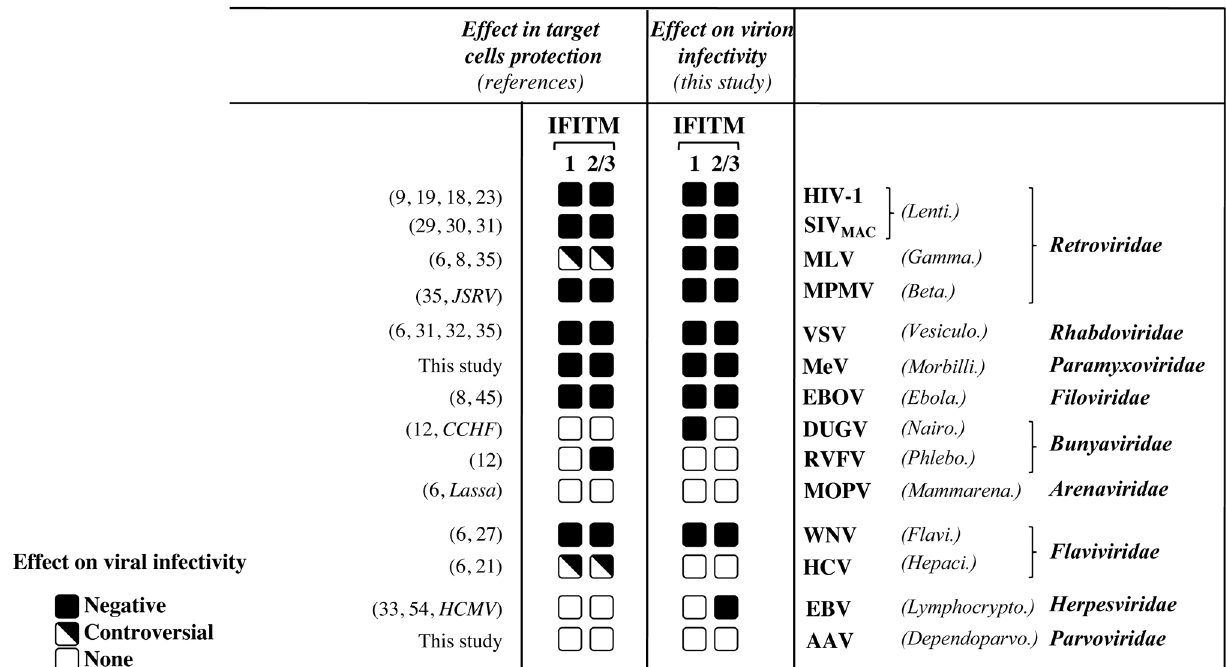
Fig 10. Comparison between the antiviral effect of IFITMs reported in the literature for the different viruses and mediated by the pool of IFITM proteins in target cells, with the negative imprinting of the virion particles infectivity reported in this study. Given their high identity, the antiviral effects of IFITM2 and 3 are presented together, separately from those of IFITM1. Variationsin the magnitude of the antiviral effects reportedin the different studies have not been taken into account here, as they are likely influenced by the specific experimental conditions used, so that the effects of IFITMs on viral infectivity are presented as negative,absent (none), or controversial, even when a single conflictingreport exists. When data in the literature was not directly comparable to ours (i.e. the same virus was not used), data was comparedto its closest relative, marked in italicus . The effects of the expressionof IFITMs in target cells againstAAV and MeV were measuredin this study and are presentedin Supplementary S6 Fig and Fig 7C, respectively.